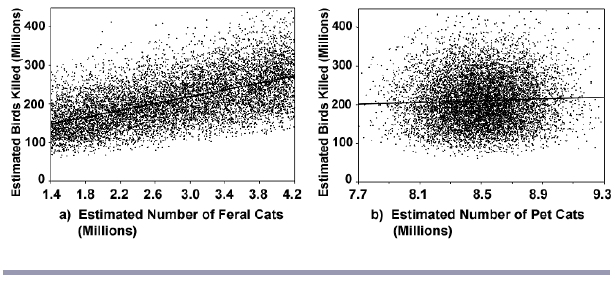
Fig. 5 . Relative sensitivity of bird kill estimates for pet cats to the range of values used for individual parameters, as measured by % of variance in kill explained in a regression model.